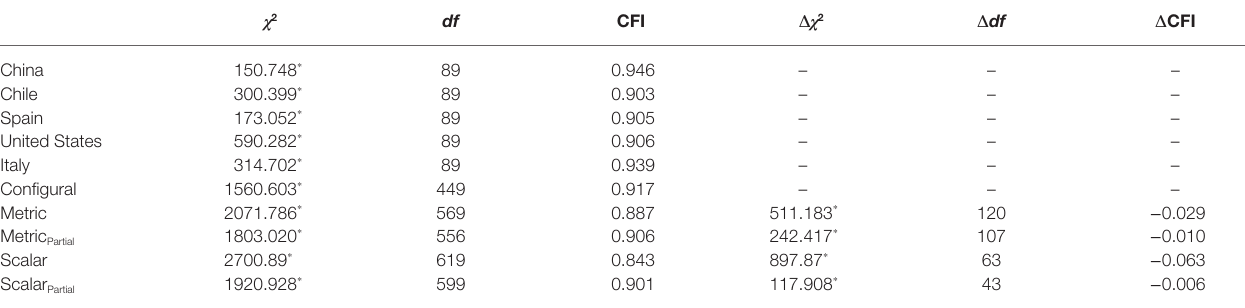
TABLE 4 | Summary of fit statistics for cross-cultural invariance of the best-fitting model (Study 2). χ 2 df